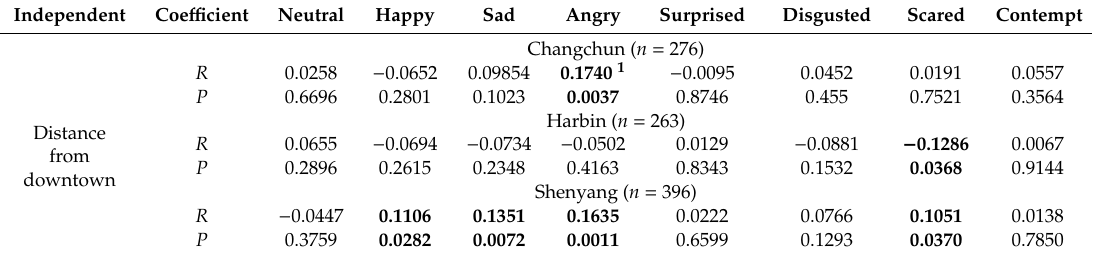
Table 3. Coe ffi cients from Pearson correlation between the distance from downtown for urban forest parks and ranked scores of eight facial expressions of visitors therein in Cities of Changchun, Harbin, and Shenyang at Northeast